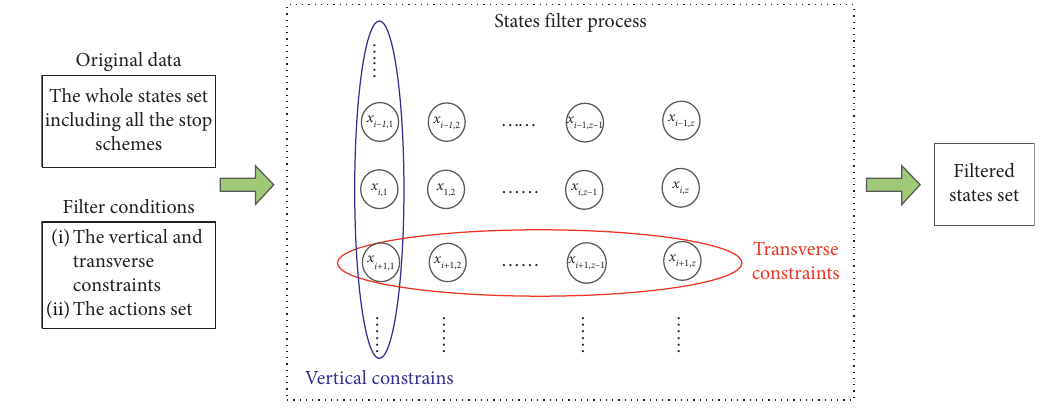
Figure 2: State filter process with